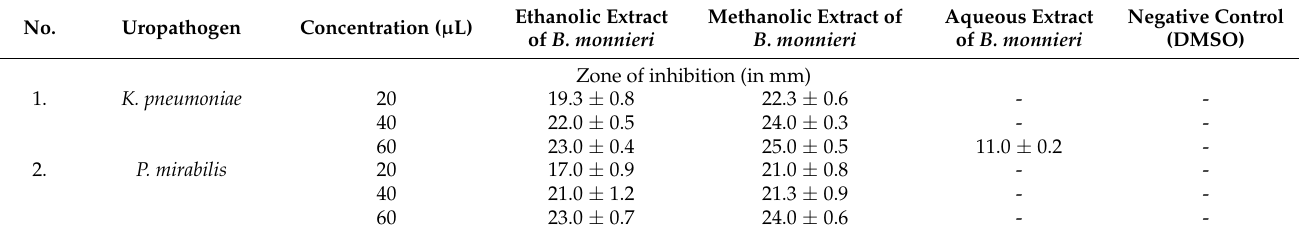
Table 1. Antimicrobial activity of crude extracts of B. monnieri against K. pneumoniae and P. mirabilis .